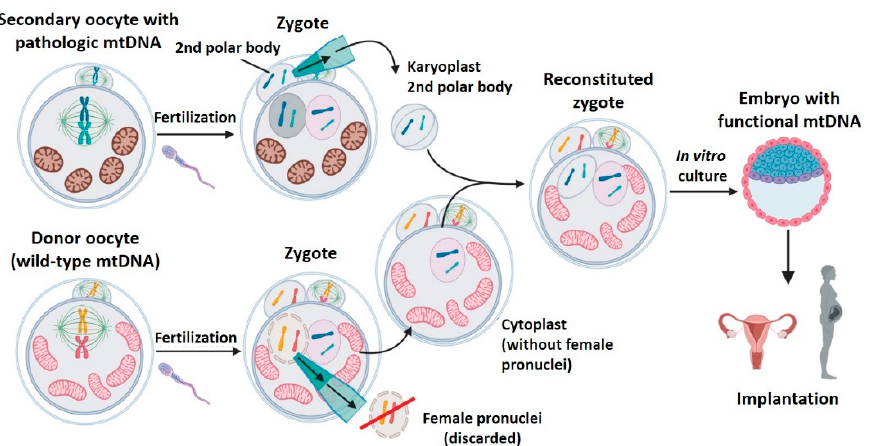
Figure 6. Second polar body transfer (PB2T). PB2T consists in transferring the PB2 from a patient’s zygote with a mtDNA mutation to a donor zygote whose female pronucleus has been previously removed. Created with BioRender.com.